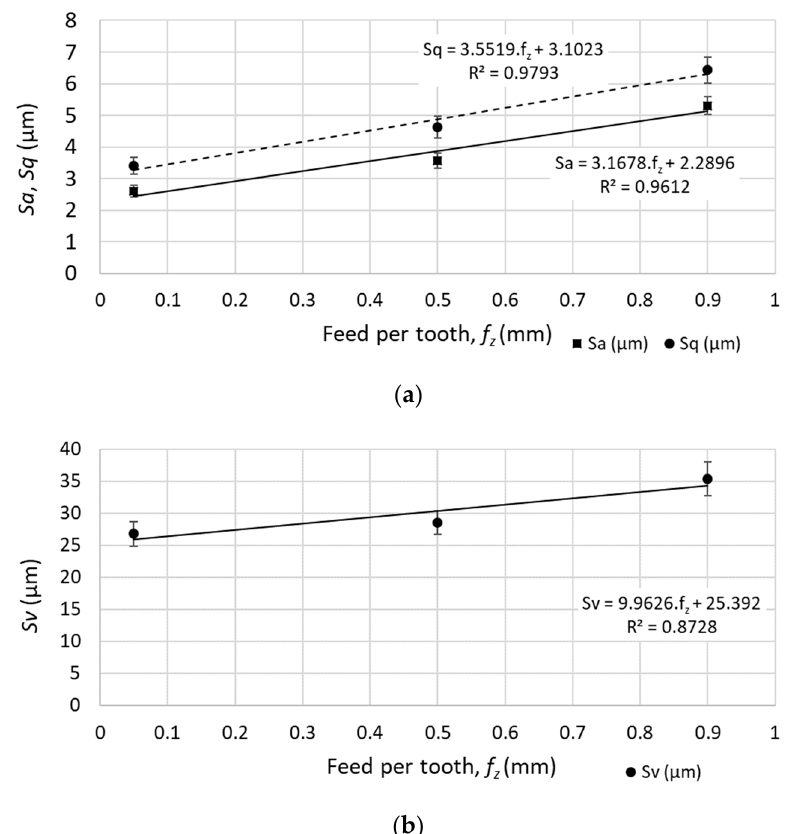
Figure 10. Surface parameters of the selected area for di ff erent feed speeds (at cutting speed v c = 200 m.min − 1 ): ( a ) Sa - average height of the selected area, Sq - root-mean-square height of the selected area; ( b ) Sv - maximum valley depth of the selected